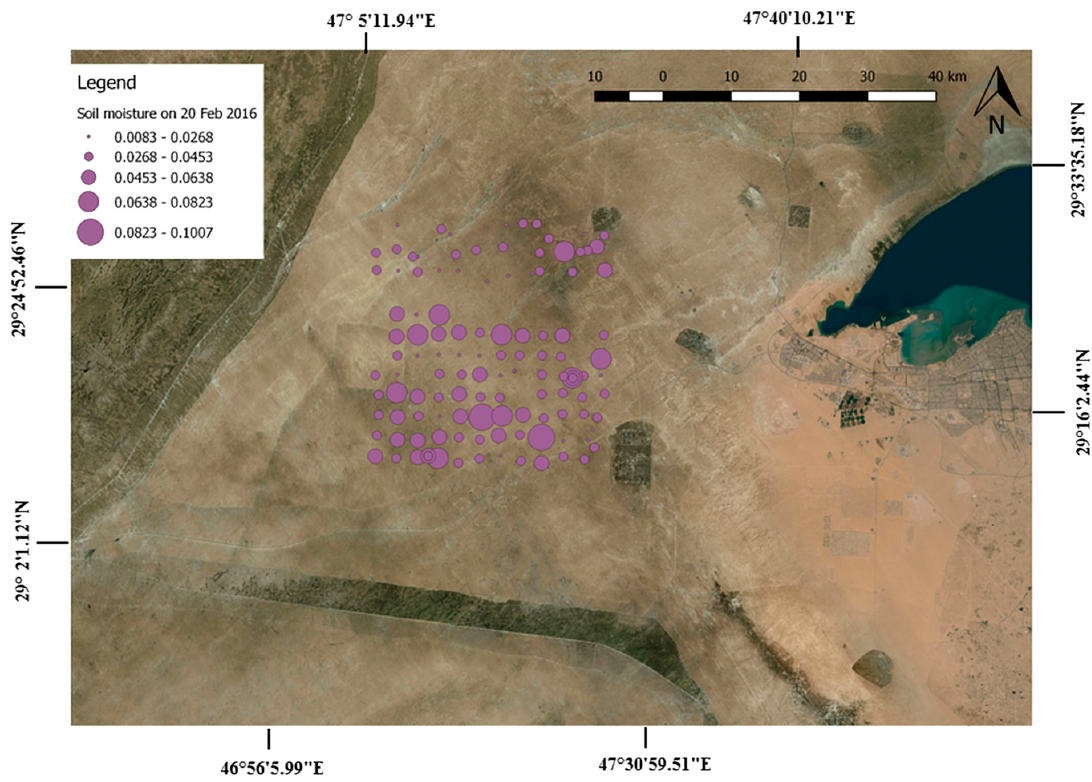
Figure 4. Spatial distribution of the measured VSM on 20 February 2016.